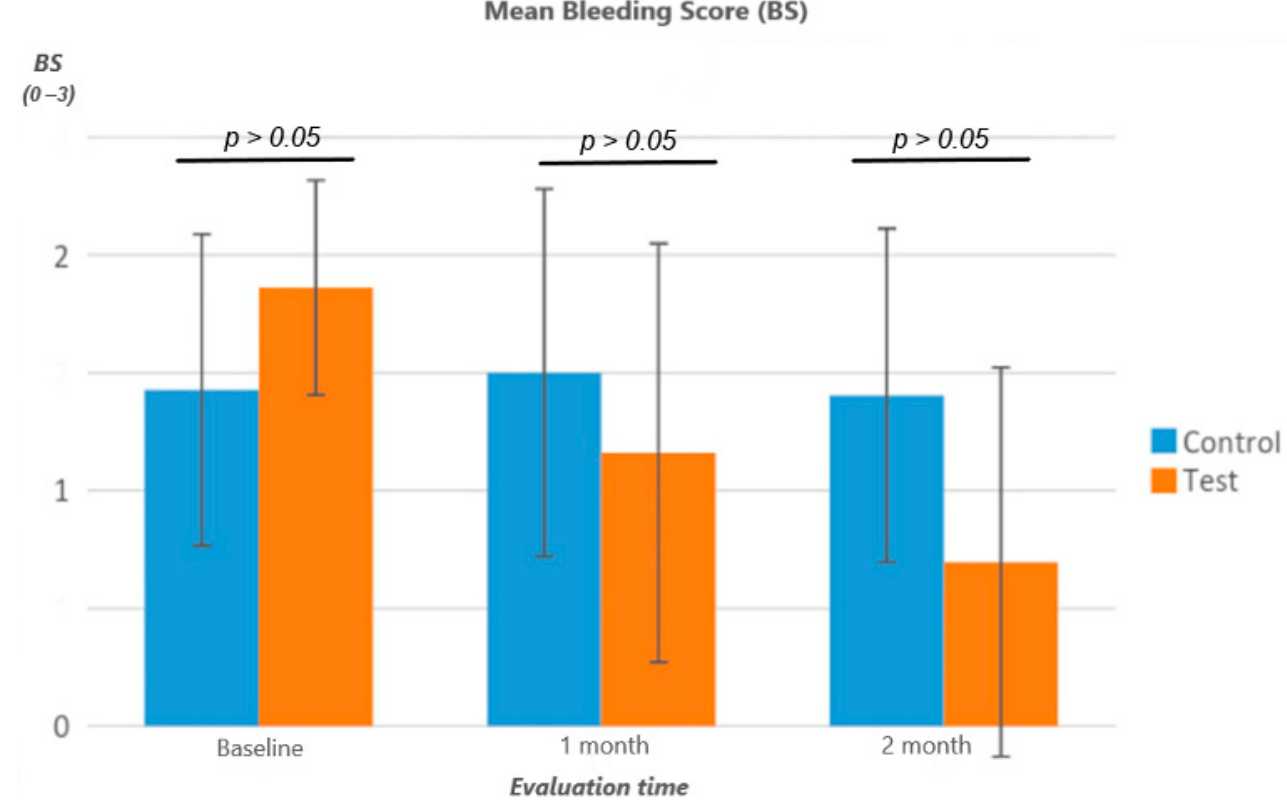
Figure 5. Bleeding Score (0–3): the figure shows the absence of intergroup differences at all the evaluation times ( p > 0.05). As to intragroup differences, a progressive significant reduction in the index was assessed in the trial group but not in the control one.